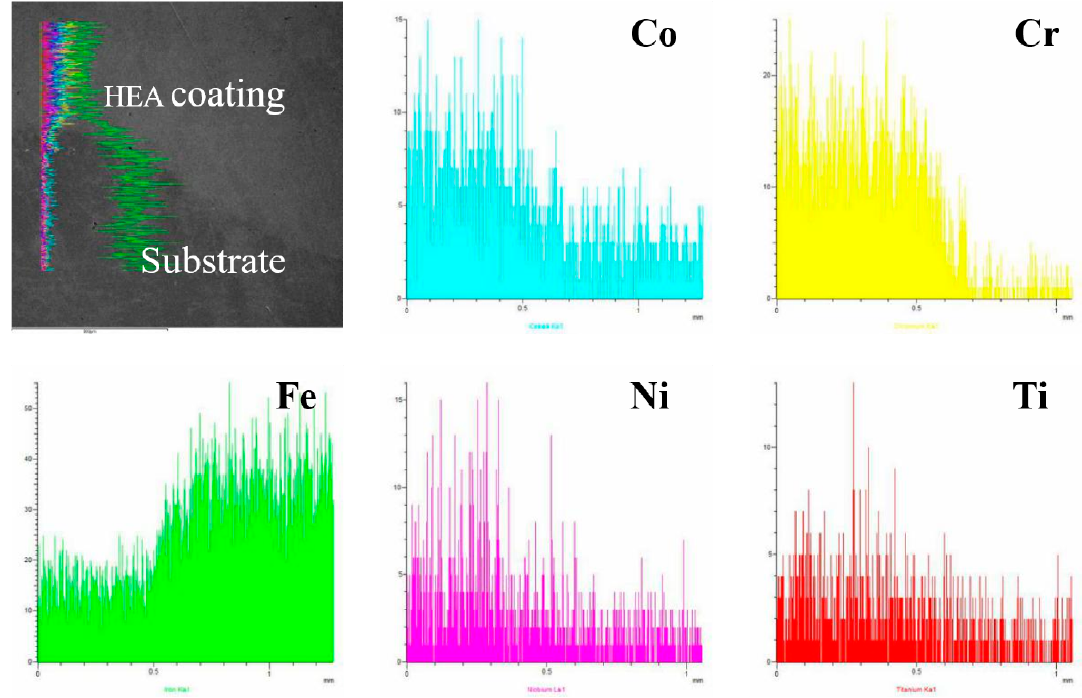
Figure 3. Microscopic morphology and element distribution in the cross-section of CoCrFeNiTi 0.5 coating by laser cladding.